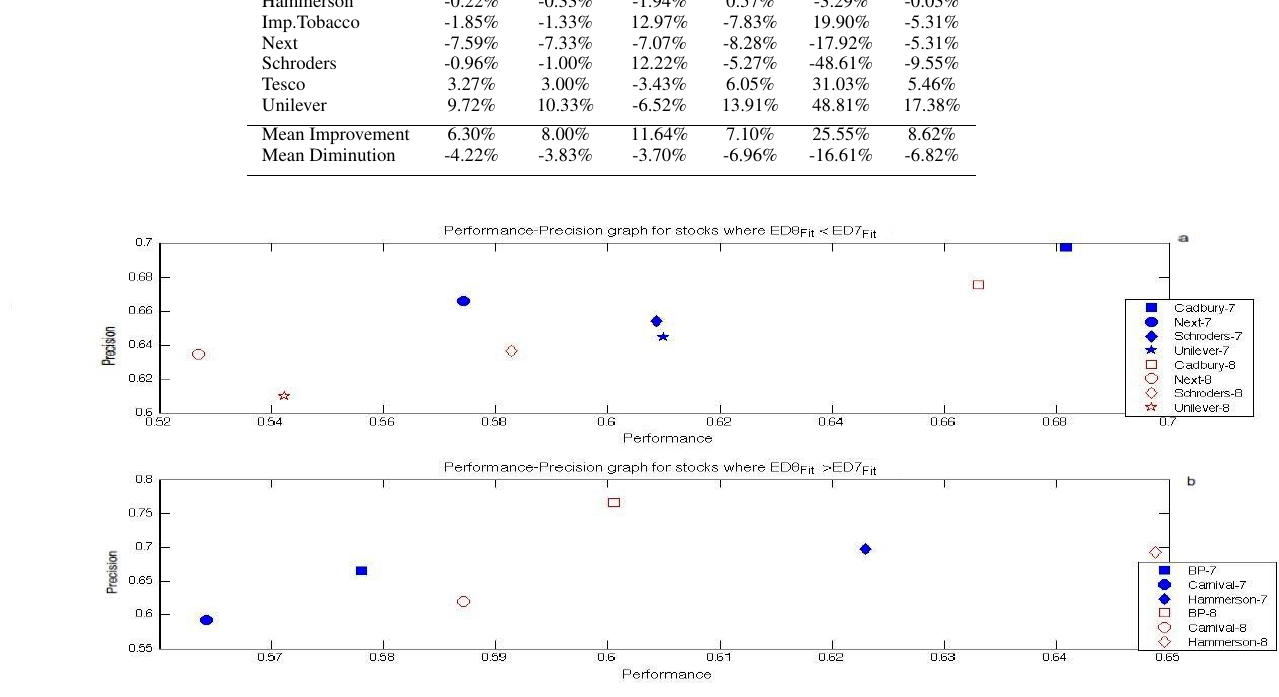
Figure 10 Performance-precision relationship. The x-axis presents the performance (average fitness) and the y-axis the average precision over 50 runs. The top graph (a) presents the stocks where ED 8 Fit < ED 7 Fit . The bottom graph (b) presents the stocks where ED 8 Fit > ED 7 Fit